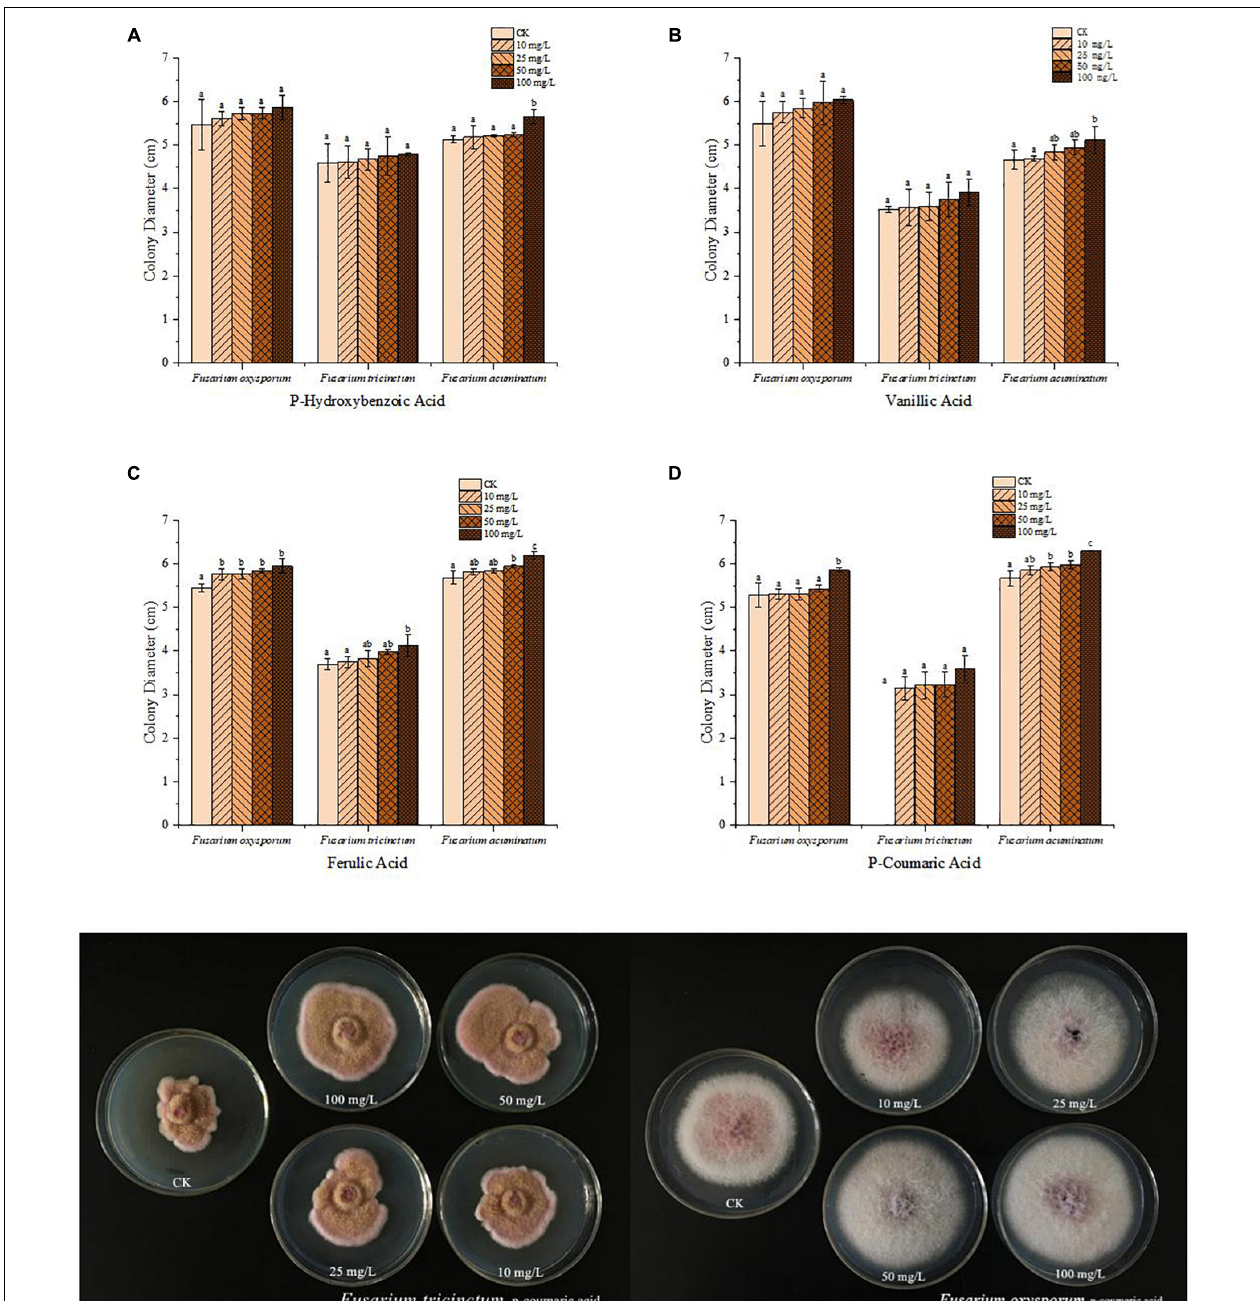
FIGURE 5 | (A–D) , represent four different phenolic acids respectively. Effects of different concentrations of phenolic acids (a- P-Hydroxybenzoic acid, b-vanillic acid, c-ferulic acid, d-p-coumaric acid) on mycelial growth of fungal pathogens that cause alfalfa root rot. Error bars indicate standard errors of the means of three repetitions. Different letters above the bars indicate significant difference according to Duncan’s multiple range test ( P = 0.05).